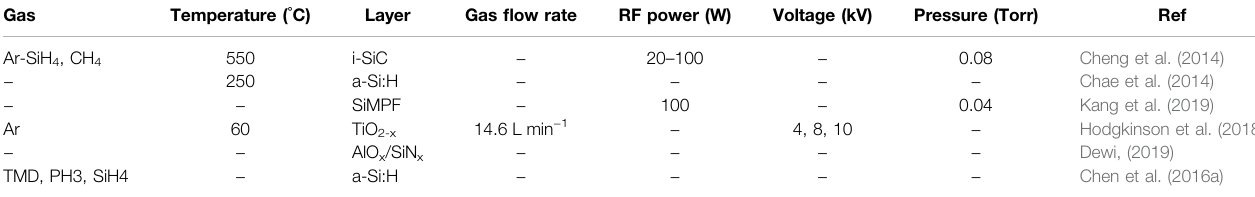
TABLE 2 | Summary of PECVD parameters used in semitransparent PV solar cells thin fi lms ’